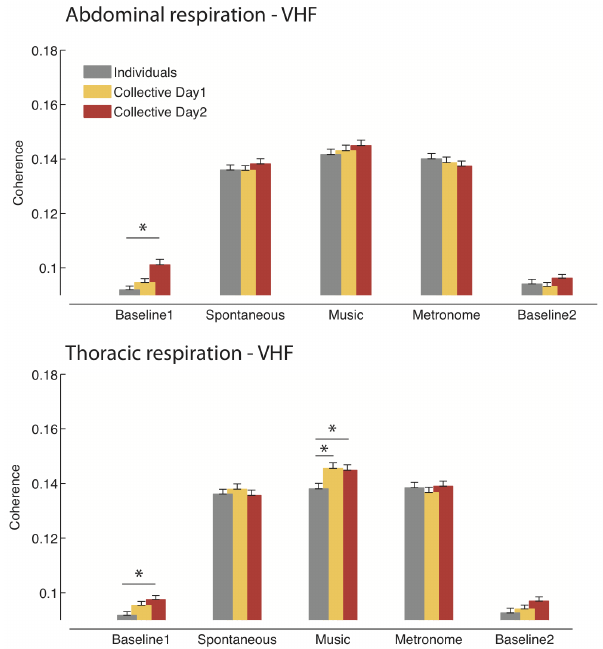
Figure 5. Coherence analysis – Respiration. The histograms show the degree of synchronization between participants for the abdominal ( top panel ) and thoracic ( bottom panel ) respiratory signals, in the very high frequency band (VHF: 0.4–2 Hz), during the five phases of the study (see Figure 4 for details). Participants in the collective measure- ment group show greater synchronization of respiration than participants in the individual measurement group. This is especially pronounced in the initial resting baseline and in the music-associated condition.